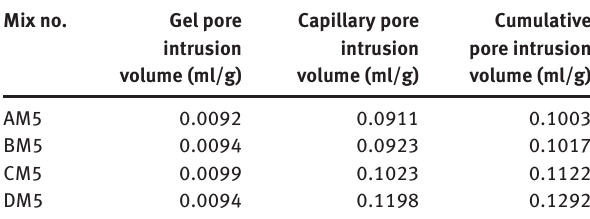
Table 4: Intrusion volume of mercury for AAFA